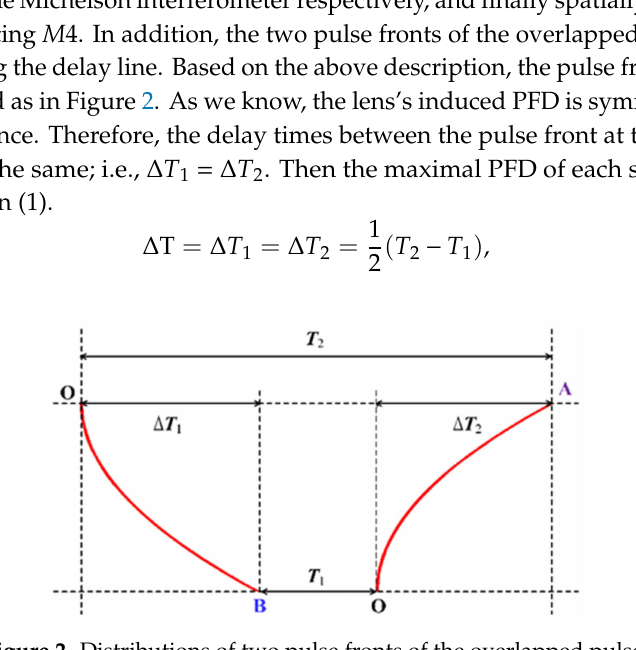
Figure 2. Distributions of two pulse fronts of the overlapped